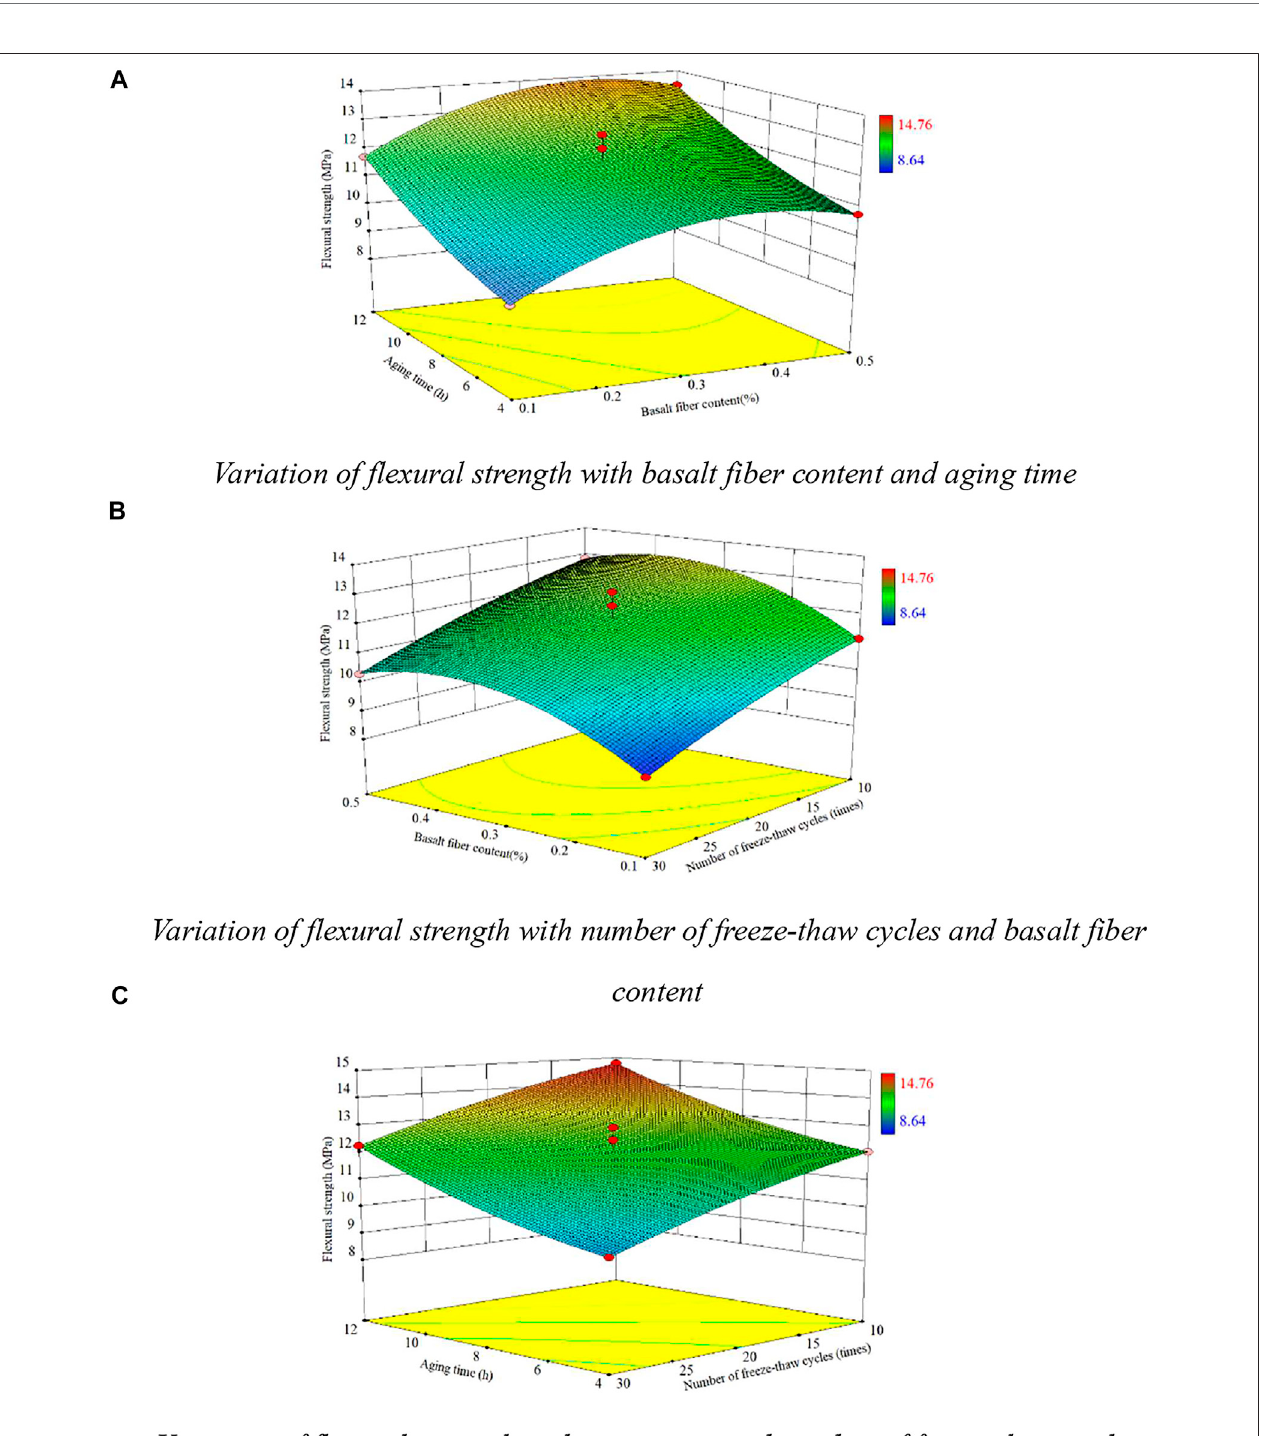
FIGURE 6 | Three-point bending test results. (A) Variation of fl exural strength with the basalt fi ber content and aging time. (B) Variation of fl exural strength with the number of freeze-thaw cycles and basalt fi ber content. (C) Variation of fl exural strength with aging time and the number of freeze-thaw cycles.